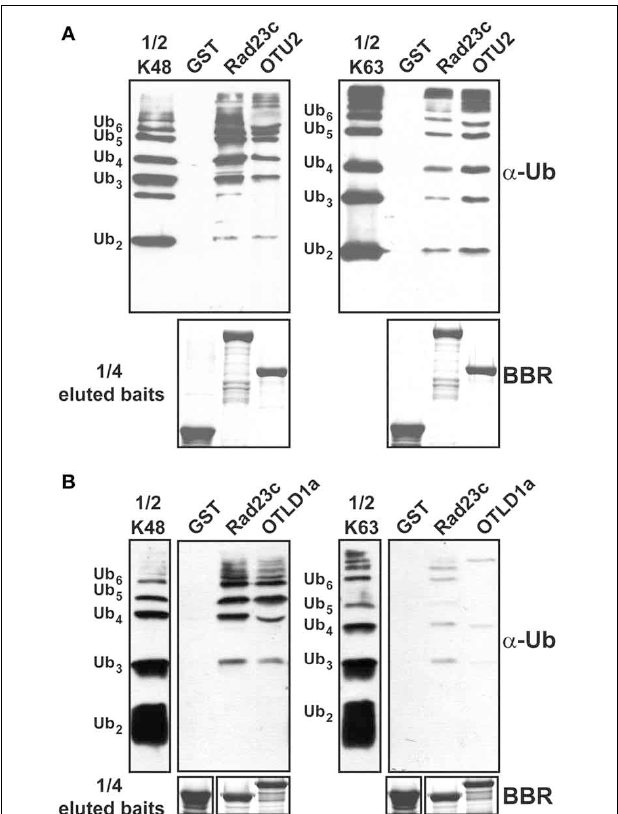
FIGURE 7 | OTU2 and OTLD1 associate with isopeptide bond-linked UB chains and have distinct preferences for different linkage types. (A) OTU2 exhibited equivalent binding affinities for K48- and K63-linked UB chains. (B) OTLD1a prefers to bind K48- over K63-linked UB chains. Five micrograms of K48- or K63-linked UB chains (2–6 units, labeled on the left) were subjected to pull down by GST-fused OTU2 (A) , OTLD1a (B) , and negative (GST) and positive (AtRAD23c) control proteins. One microgram of the input chains (1/2 K48 or K63) and two-fifths of the eluted pulled-down products were analyzed by immunoblotting with α -Ub. One-tenth of the eluted pulled-down products (1/4 eluted baits) were visualized by Brilliant Blue R staining (BBR) to confirm equally immobilized